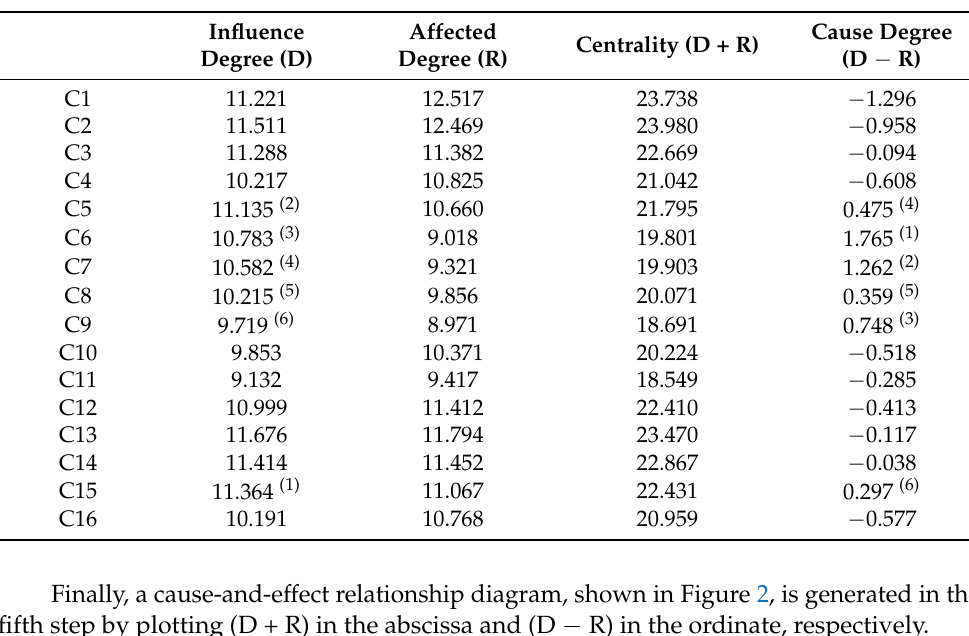
Table 12. Comprehensive influence scores.